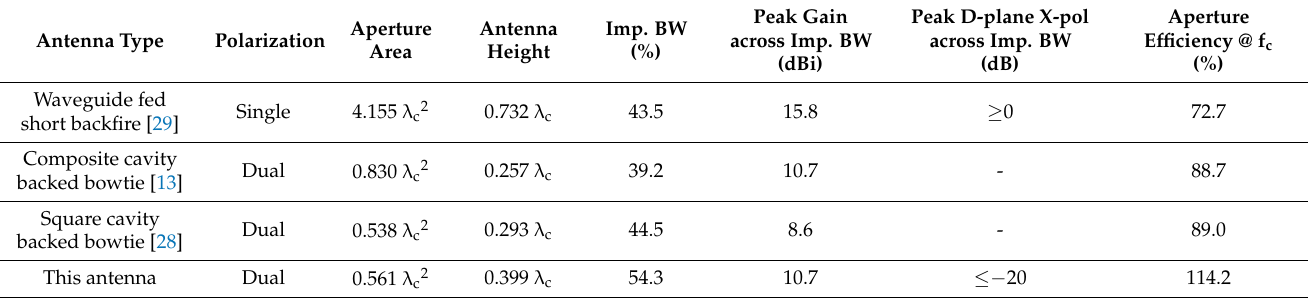
Table 3. Performance comparison of the proposed antenna with similar